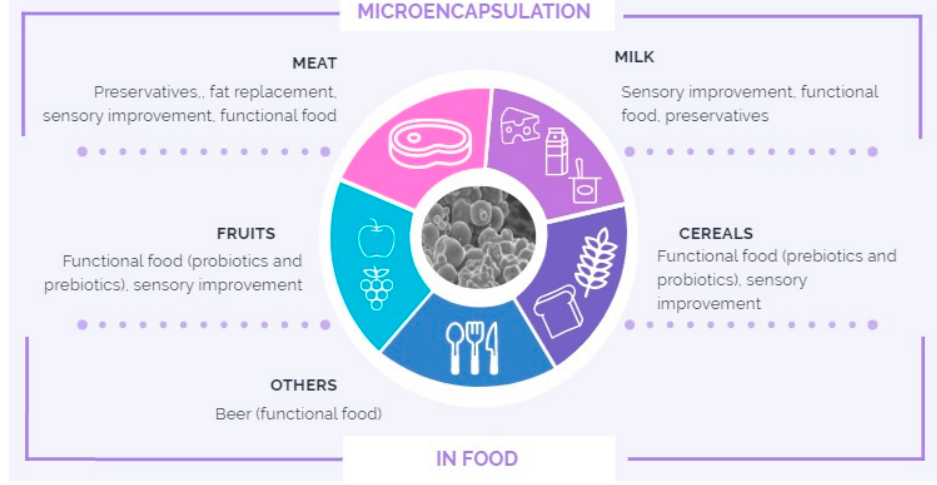
Figure 1. Main applications of microcapsules in food.